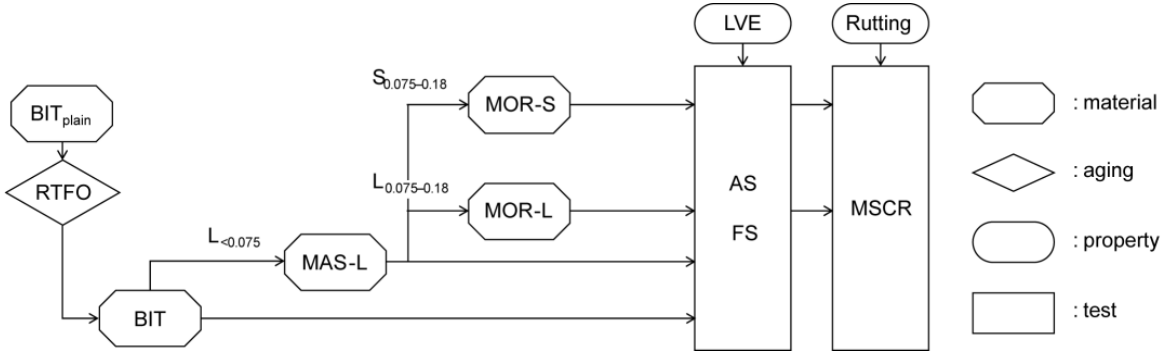
Figure 2. Schematization of the experimental plan.